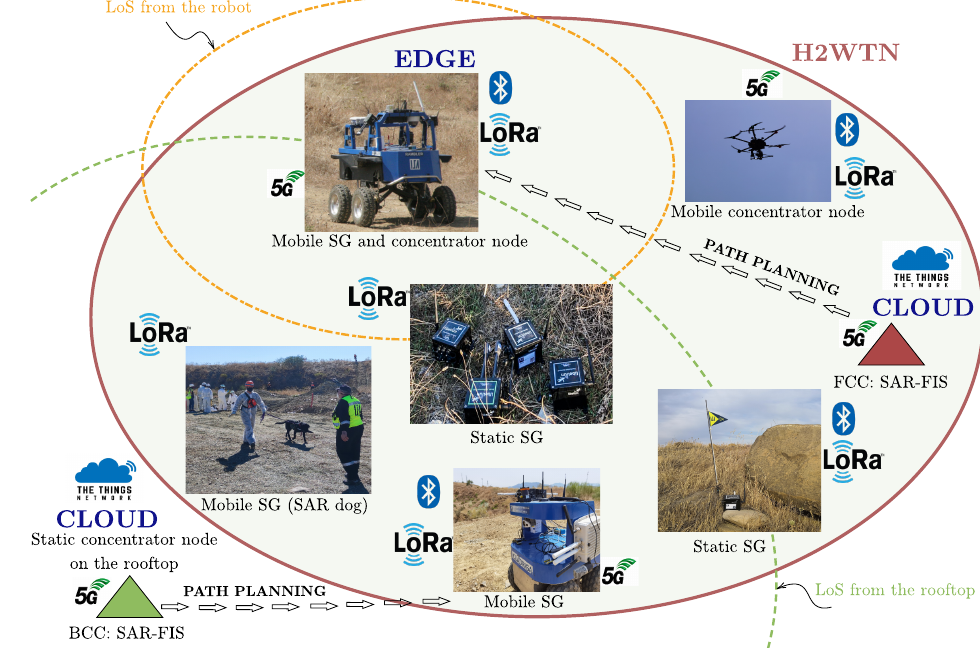
Figure 3. Proposed H2WTN architecture for the SAR field